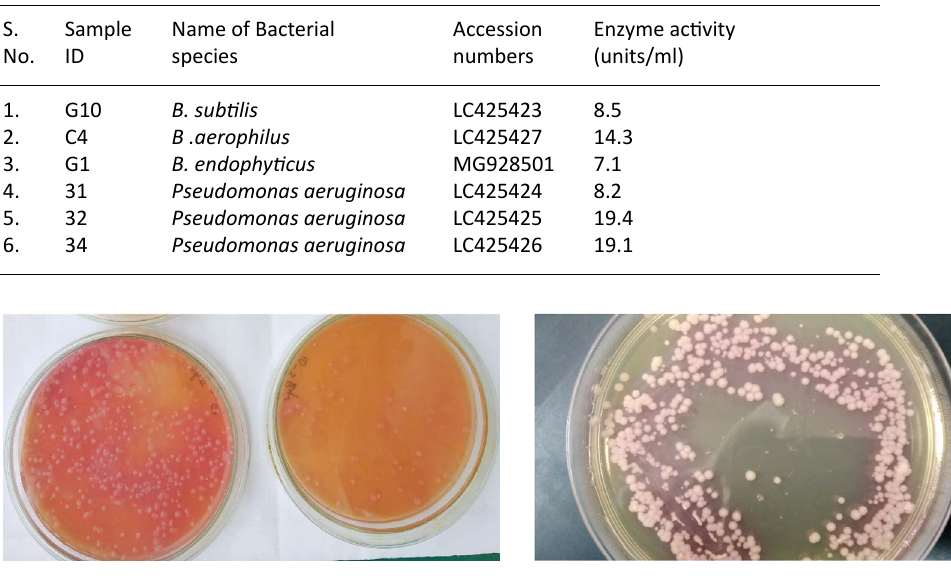
Fig. 1 & 2. Colonies producing pink zone (L asparaginase producers) on modified BHI infusion media